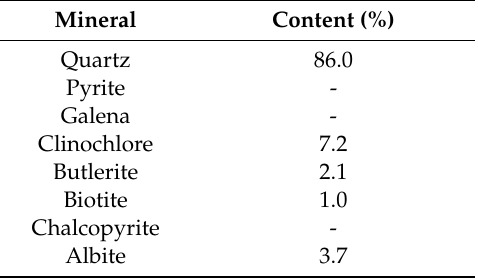
Table A2. Mineralogical characterization of auriferous ore.